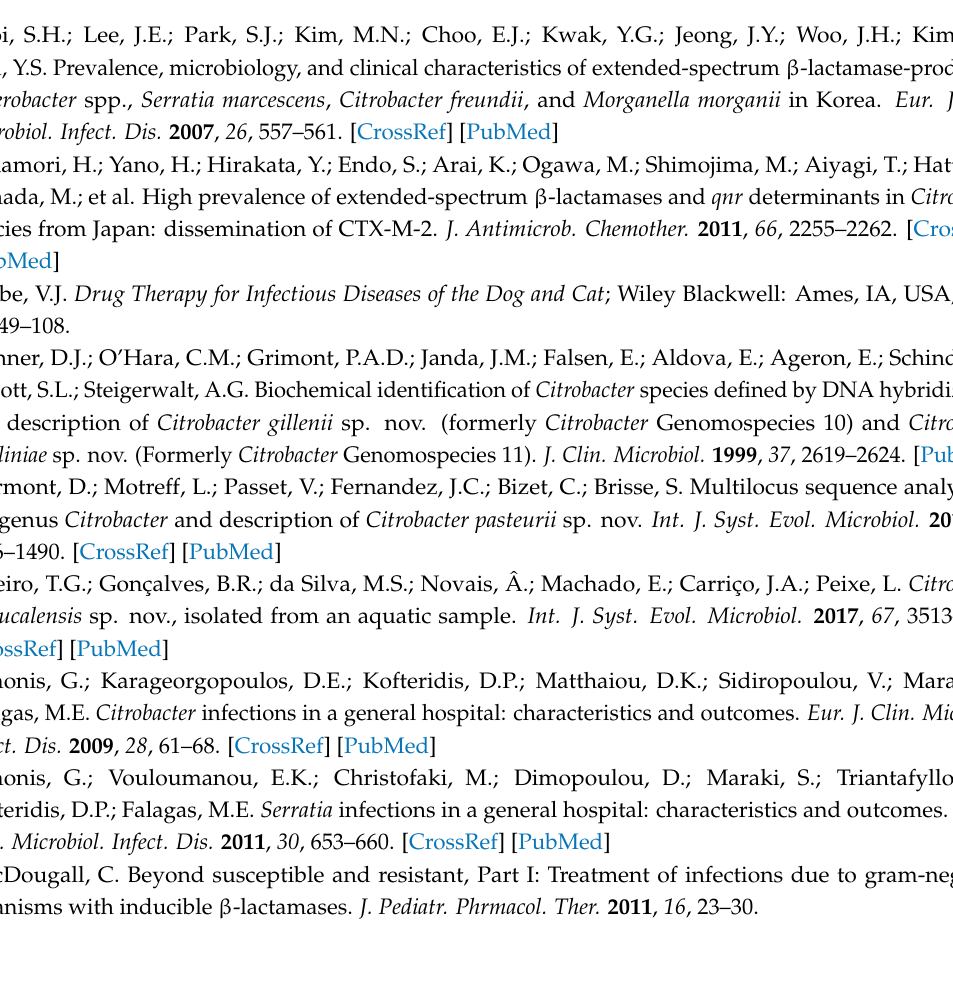
Table S1: The details of Serratia spp. and Citrobacter spp. isolates used in this